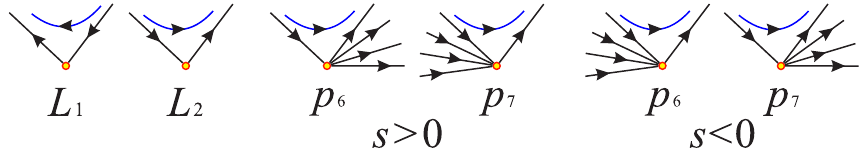
Figure 11. There is an one-dimensional stable manifold in the region I and one-dimensional unstable manifold in regions II and III on the local chart U 1 .